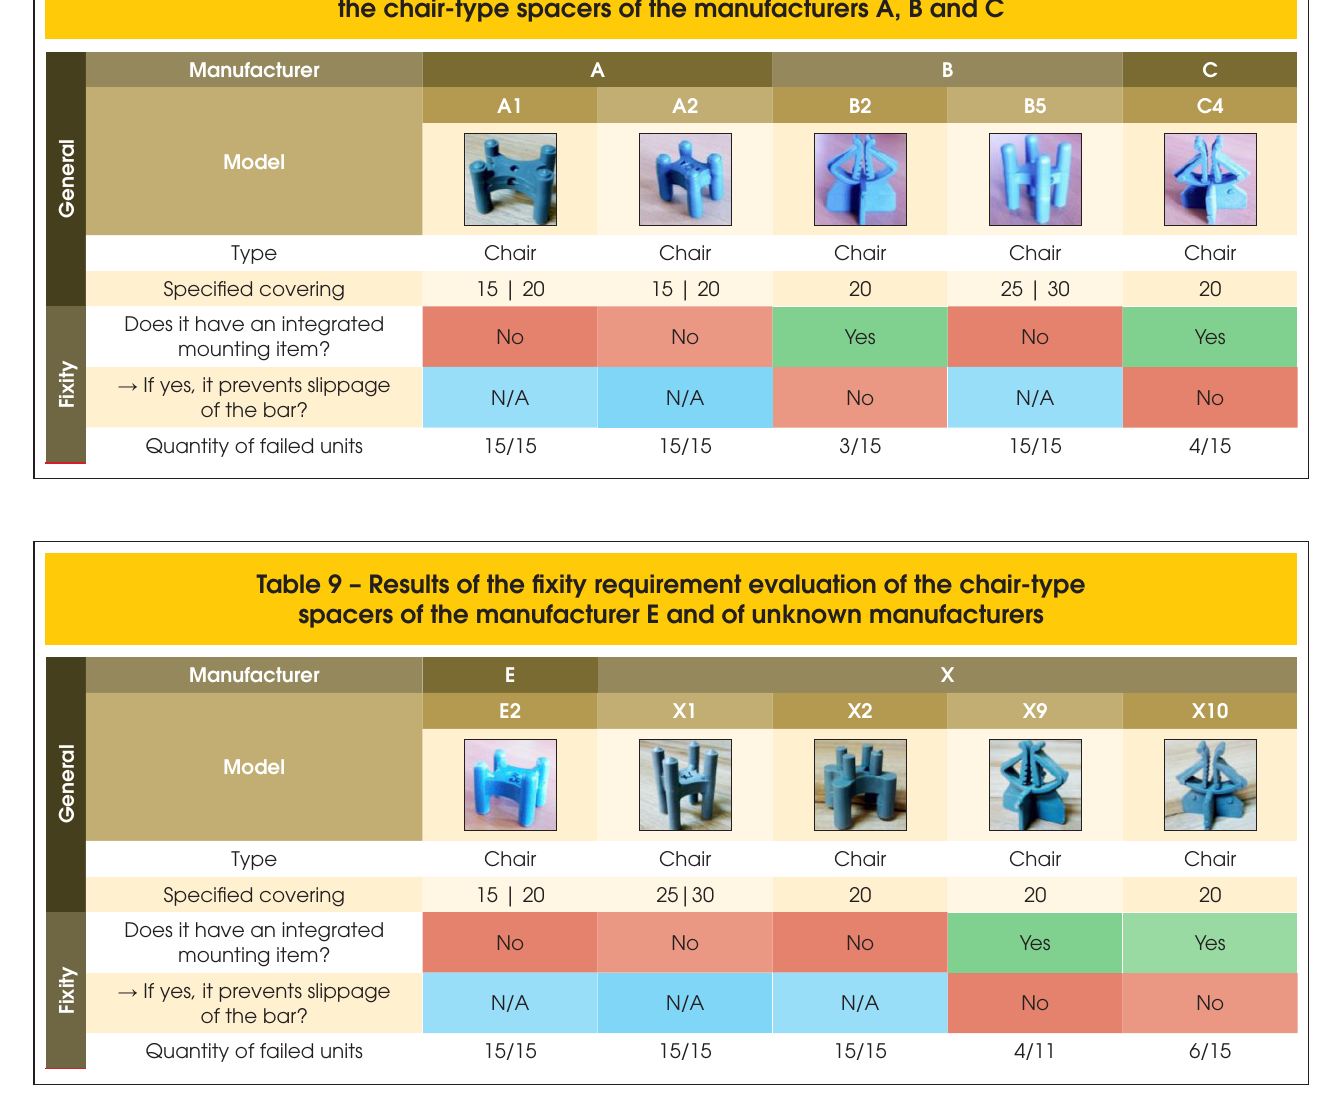
Table 8 – Results of the fixity requirement evaluation of